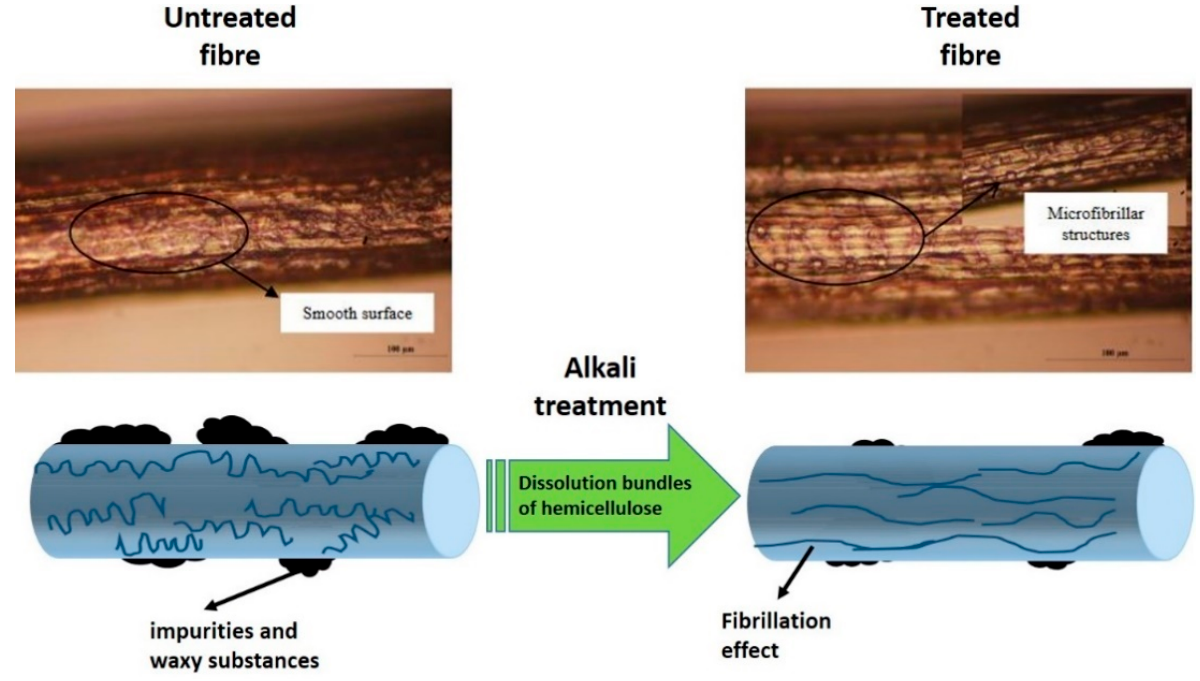
Figure 8. Schematic mechanism of the untreated and treated natural fiber using alkaline treatment. However, excess of alkali would lead to delignification of cellulose which able to damage or weaken the structure. Rodriguez et al. [105] indicate limitations on the ex- tremely high concentration of alkali and/or too long time taken of the alkaline treatment with various concentrations. From all of the mentioned concentrations, it was stated that 5 to 6% alkaline treatment with treatment duration of 2 to 3 h is sufficient enough to re- move the hemicellulose and lignin [106]. The significant effect of mercerization or alkaline treatment on flexural properties of unidirectional PP/flax composites is listed in Table 11. As expected, the value of flexural strength for the treated flax reinforced PP composite was higher than that of untreated flax reinforced PP composite. Based on study by Zin et al. [107], the study showed that the optimum alkaline treatment for banana fiber is 6% NaOH concentration with a 2-h immersion period, which resulted in 371 MPa tensile strength, 12.45 GPa tensile modulus and 3.96 MPa interfacial shear strength. The tensile strain increases with higher NaOH concentration. As the concentration increases beyond 6%, the mechanical properties of banana fiber deteriorate significantly. Table 11. Flexural strength of untreated and treated flax reinforced PP composites. Types of Fiber Flexural Strength (MPa) Untreated flax 77 Treated flax